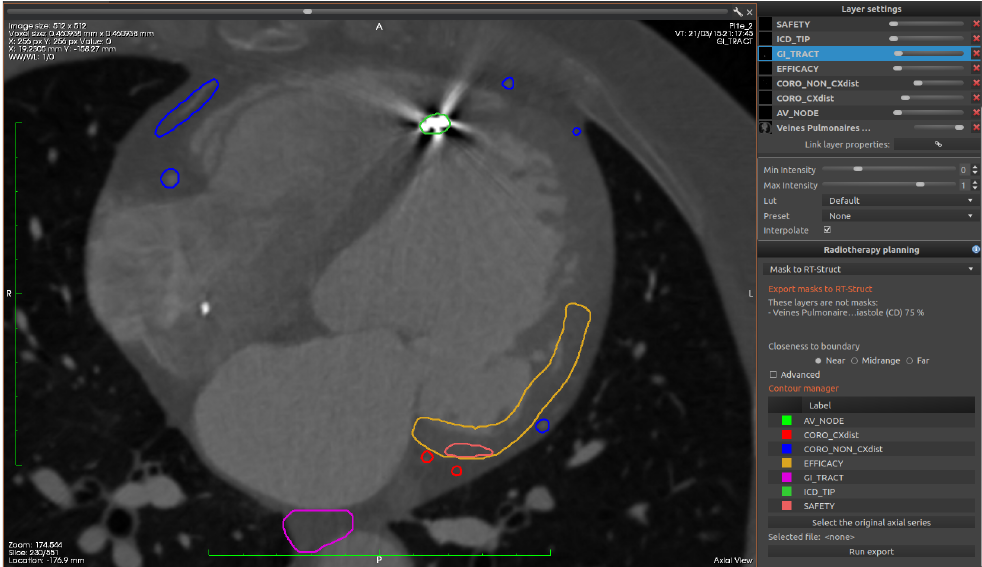
Figure 8. Automatic contouring of targets and organs at risk. The contours can be exported to the standard DICOM Rt-Struct format. Each ablation target and organ at risk is segmented with a color code: the list of contour names is displayed in a table in the right part of the application, as shown in this